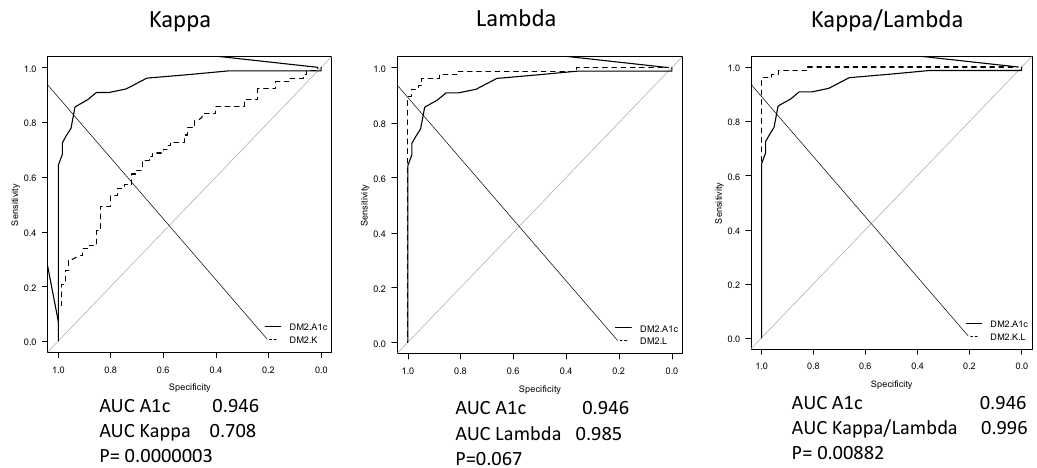
Figure 3. Comparisons of ROC-AUC between FLC variables and HbA1c. The ROC-AUC of the FLC κ / λ ratio was larger than that of HbA1c (Adapted from [13]).